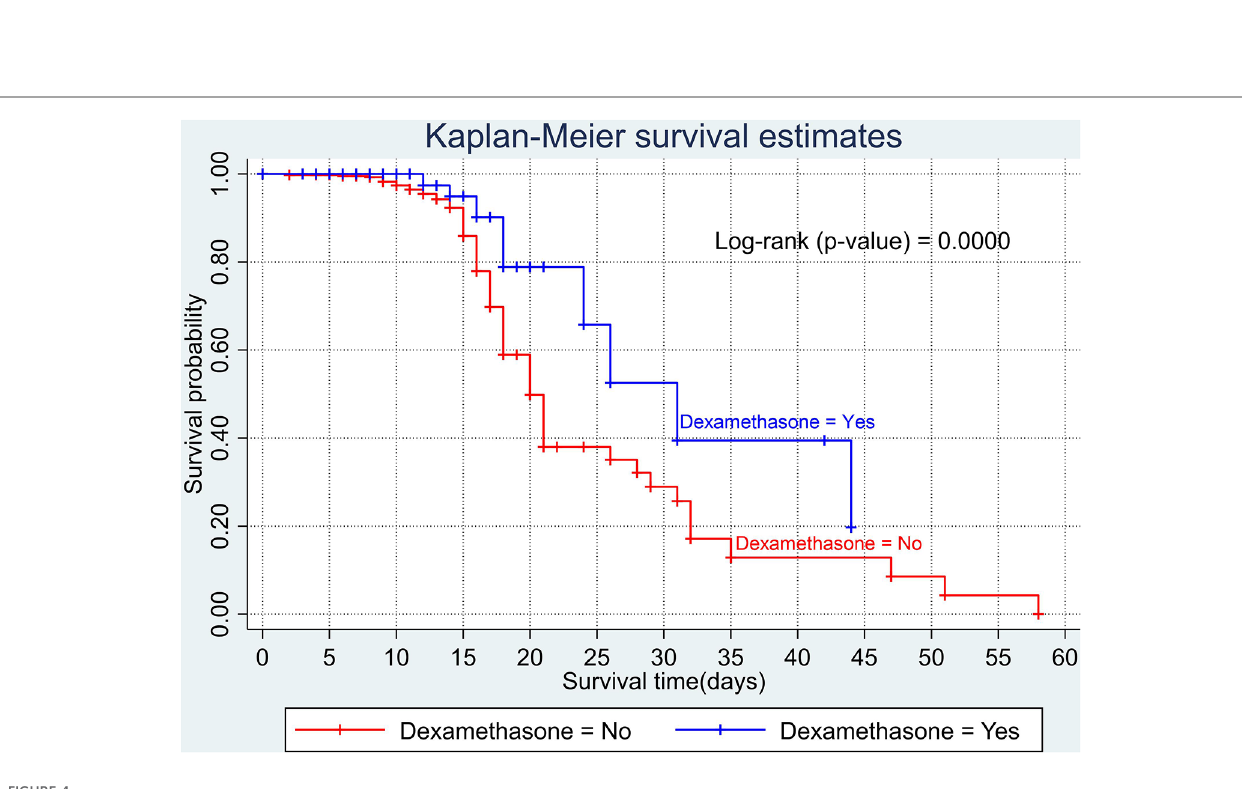
FIGURE 4 Kaplan – Meier survival curve by dexamethasone treatment among adult COVID-19